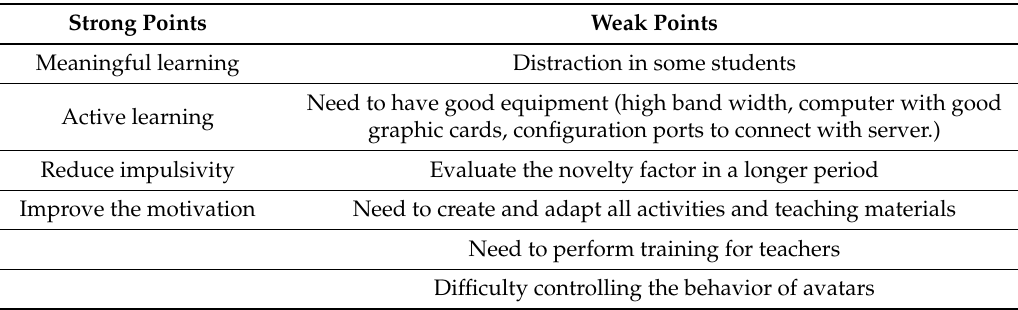
Table 6. Strong and weak points